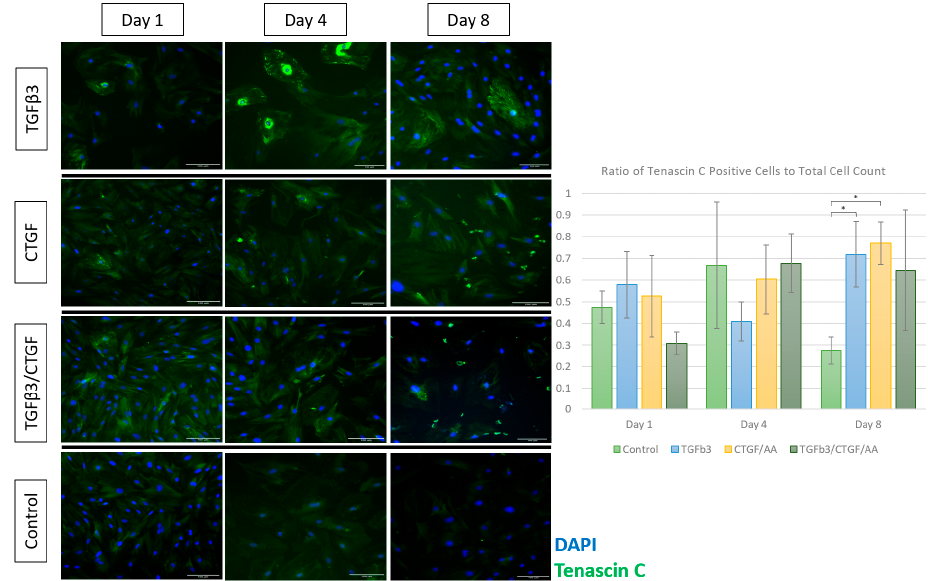
Figure 5. Expression of tenascin C (green) in rAdMSCs exposed to TGF- β 3 (10 ng/mL), CTGF (100 ng/mL) with 50 μ g/mL ascorbic acid, or TGF- β 3 (10 ng/mL), CTGF (100 ng/mL), and 50 μ g/mL ascor- bic acid at Days 1, 4, and 8 of culture; cell nuclei counterstained with DAPI (blue). Immunofluores- cence staining of tenascin C was significantly upregulated in the groups treated with CTGF/ascorbic acid (AA) and with TGF β 3 on Day 8. Scale bar = 100 μ m. “*” represents p < 0.05 in pairwise compar- ison. Rat AdMSC displayed a temporal upregulation of tenomodulin expression in re- sponse growth factor exposure (Figure 6). Cells exposed to CTGF/AA exhibited a signifi- cantly increased tenomodulin expression on Day 1 compared to the unexposed controls ( p = 0.0420), and the relative magnitude expression remained consistent throughout the culture period. The cells exposed to TGF- β 3 displayed a delayed but marked upregulation of tenomodulin expression on Day 4 ( p < 0.001). Cells exposed to TGF- β 3, CTGF/AA, and TGF- β 3/CTGF/AA displayed a significantly greater tenomodulin expression compared to the unexposed controls on Day 8 ( p = 0.0130, p = 0.0013, and p = 0.0041, respectively).